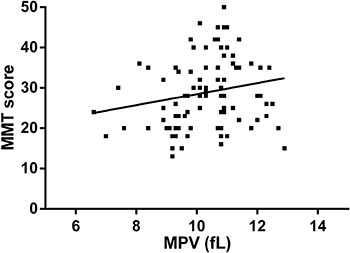
Correlation between mean platelet volume (MPV) and manual muscle test (MMT)
score in patients with polymyositis (PM).